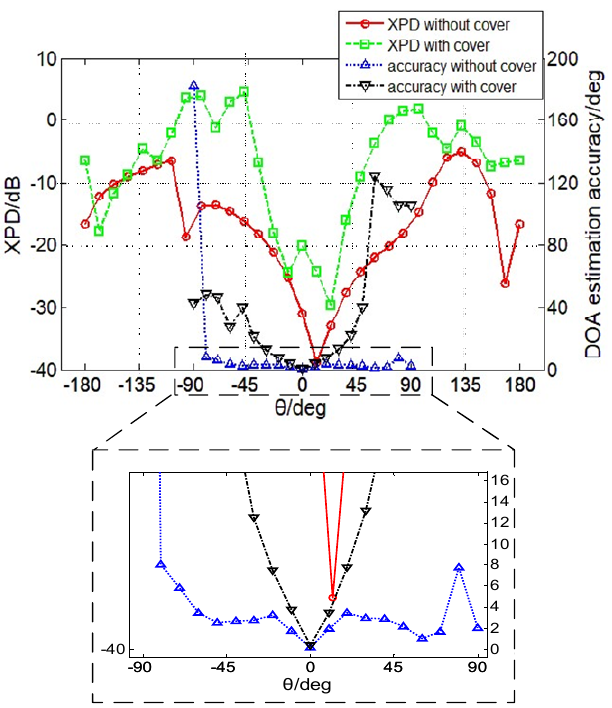
Figure 16. Effect of the mechanical supporting cover on anchor antennas: XPD against DOA (θ); DOA estimation accuracy against DOA (θ).